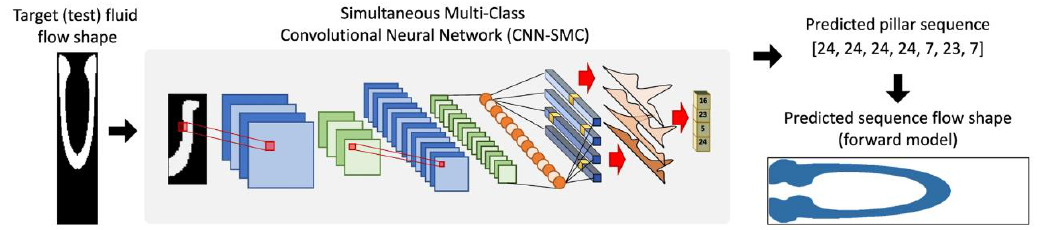
Figure 3. Application of deep learning for nerve cell segmentation. This photograph is directly cropped from the corresponding papers [44]. Reproduced with permission from Springer Nature Copyright